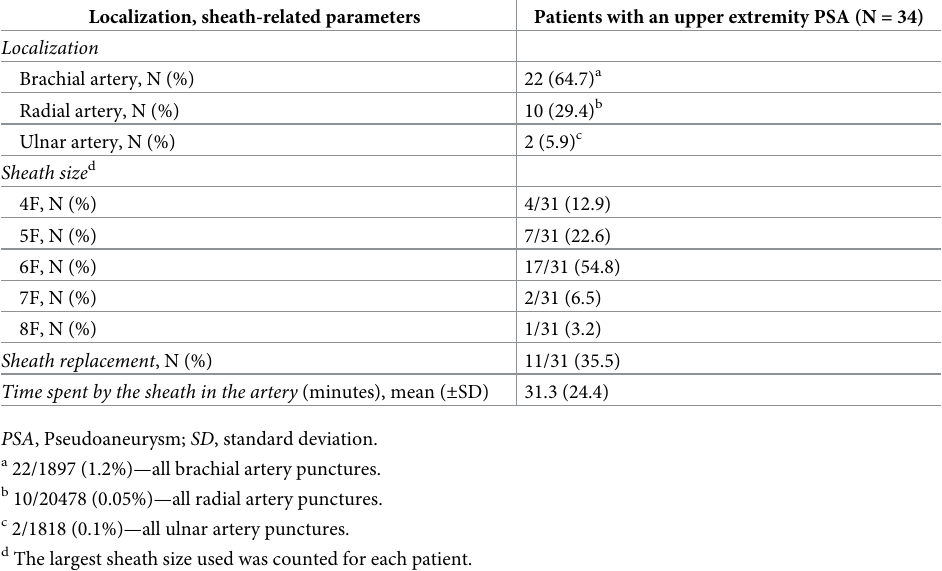
Table 3. Localization and sheath-related parameters of patients with an upper extremity pseudoaneurysm. Localization, sheath-related